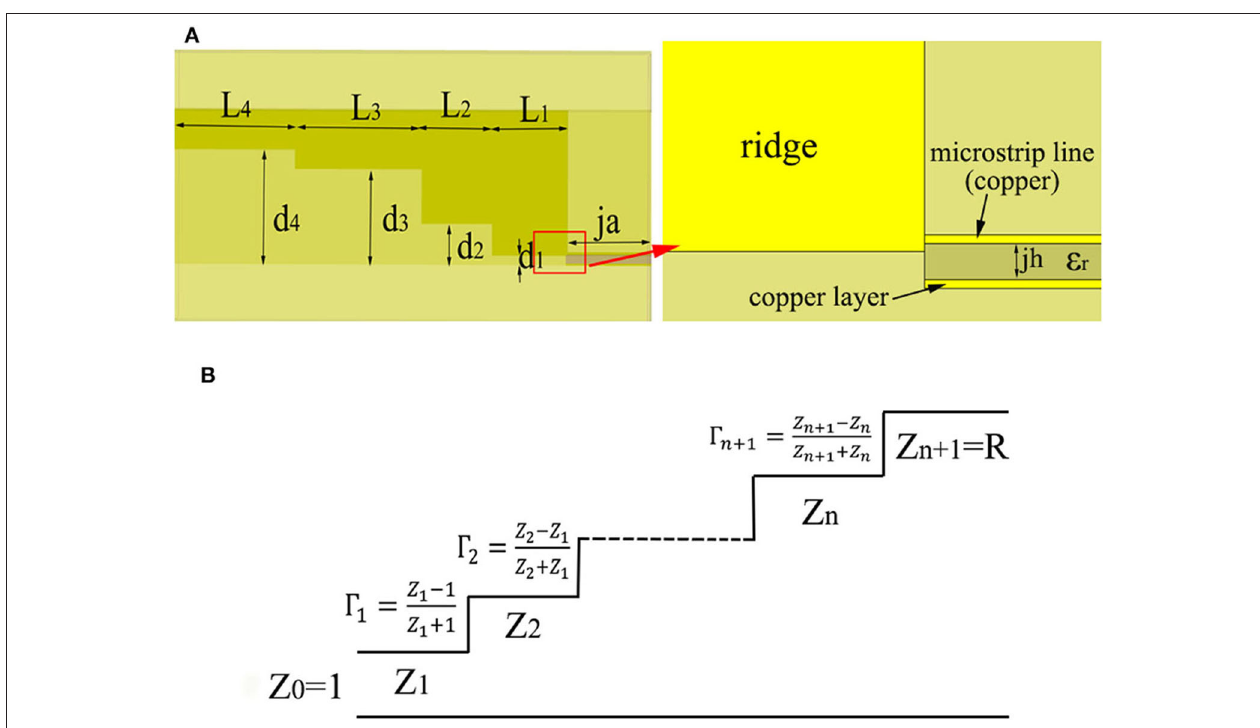
FIGURE 2 | (A) Side-view of the stepped ridge (left) and the details at the junction between the ridge and the microstrip line (right). (B) Schematic diagram of the quarter-wavelength multi-section impedance converter.